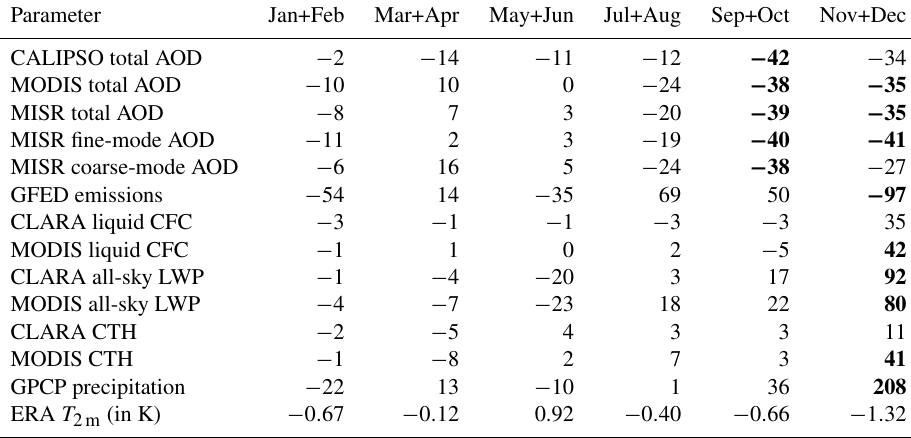
Table 1. Relative change (in percent for all data except for T 2m in K) of 2-monthly aerosol, GFED BC + OC emissions, cloud, precipitation and T 2m parameters over southern China from 2006 to 2015 (2007 to 2015 for CALIPSO AOD). Significant changes are indicated with